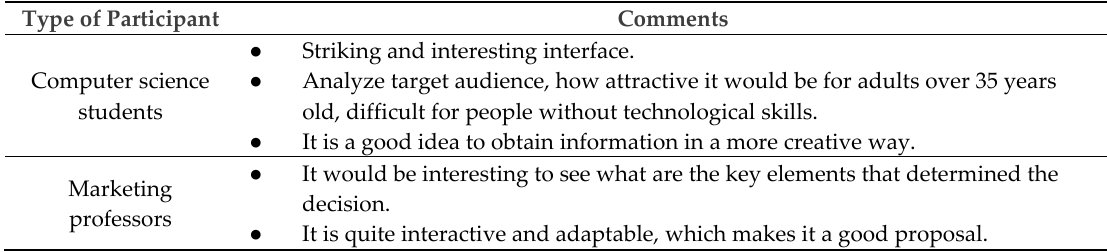
Table 4. Summary of participant